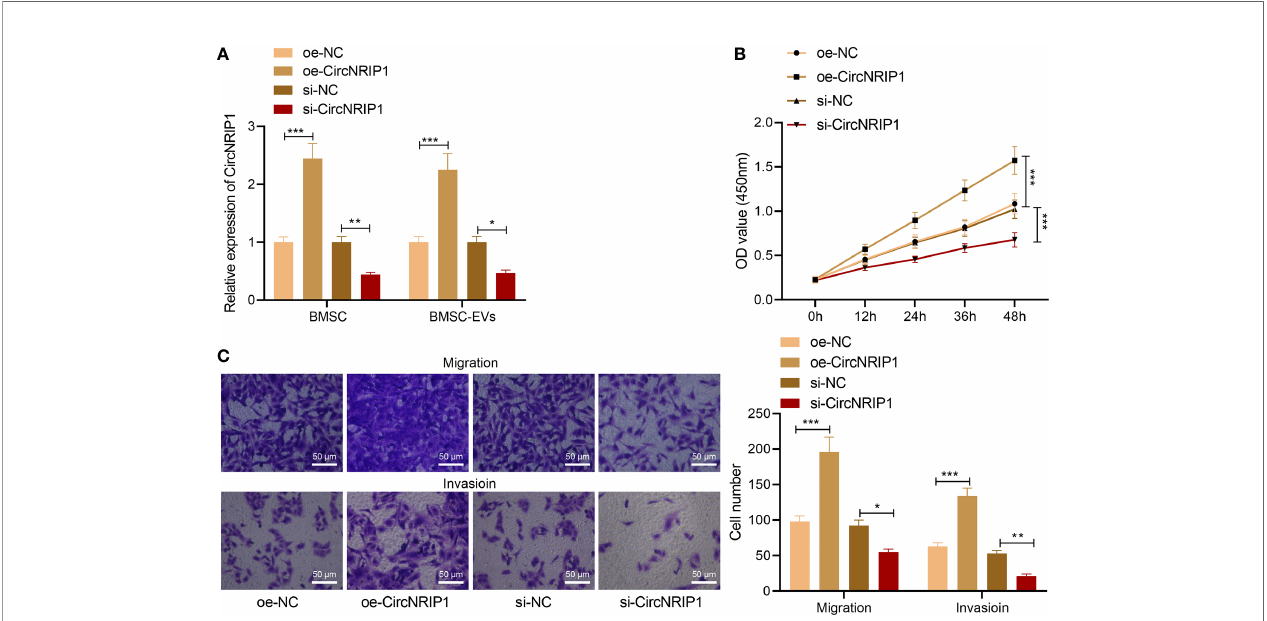
FIGURE 3 | circNRIP1 loaded by BMSC-EVs promotes the malignant phenotypes of osteosarcoma cells. (A) Expression of circNRIP1 determined by RT-qPCR in EVs derived from BMSCs treated with oe-circNRIP1 or si-circNRIP1. (B) CCK-8 assay to detect the viability of MG63 cells co-cultured with EVs from BMSCs treated with oe-circNRIP1 or si-circNRIP1. (C) Transwell assay to detect the migration and invasion of MG63 cells co-cultured with EVs from BMSCs treated with oe- circNRIP1 or si-circNRIP1. * p < 0.05. ** p < 0.01. *** p < 0.001. Data are shown as mean ± standard deviation of three technical replicates. Data among multiple groups were compared with one-way ANOVA, followed by Tukey ’ s post hoc tests. The repeated measures ANOVA with Bonferroni post hoc test was applied for the comparison of data at different time